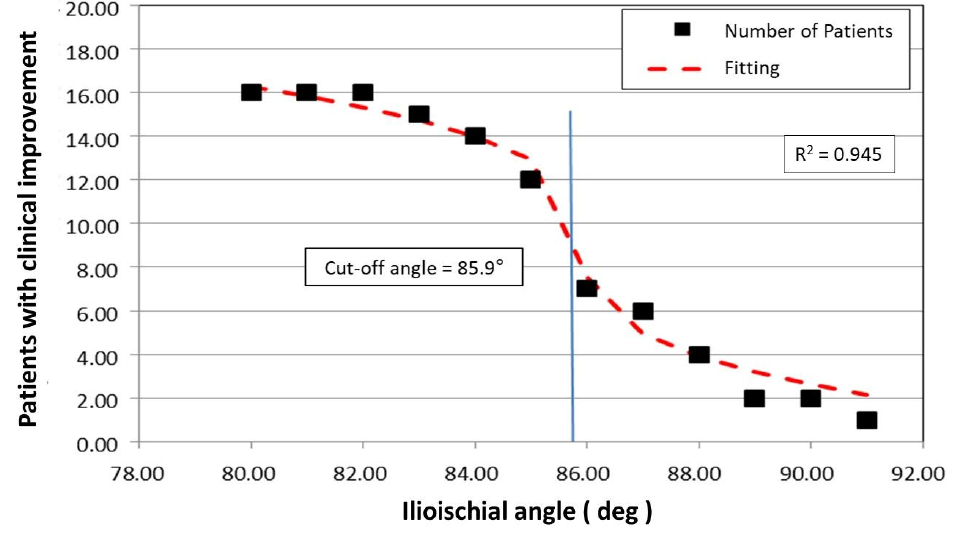
Figure 6. Graphic of the mathematical function that determines the limit value of the ilioischial